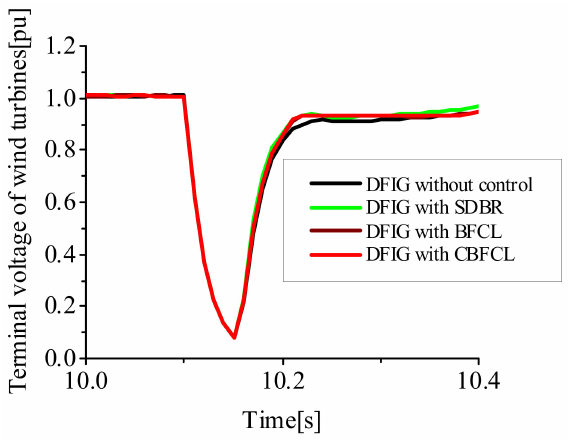
Figure 22. Terminal voltage of DFIG wind turbine.